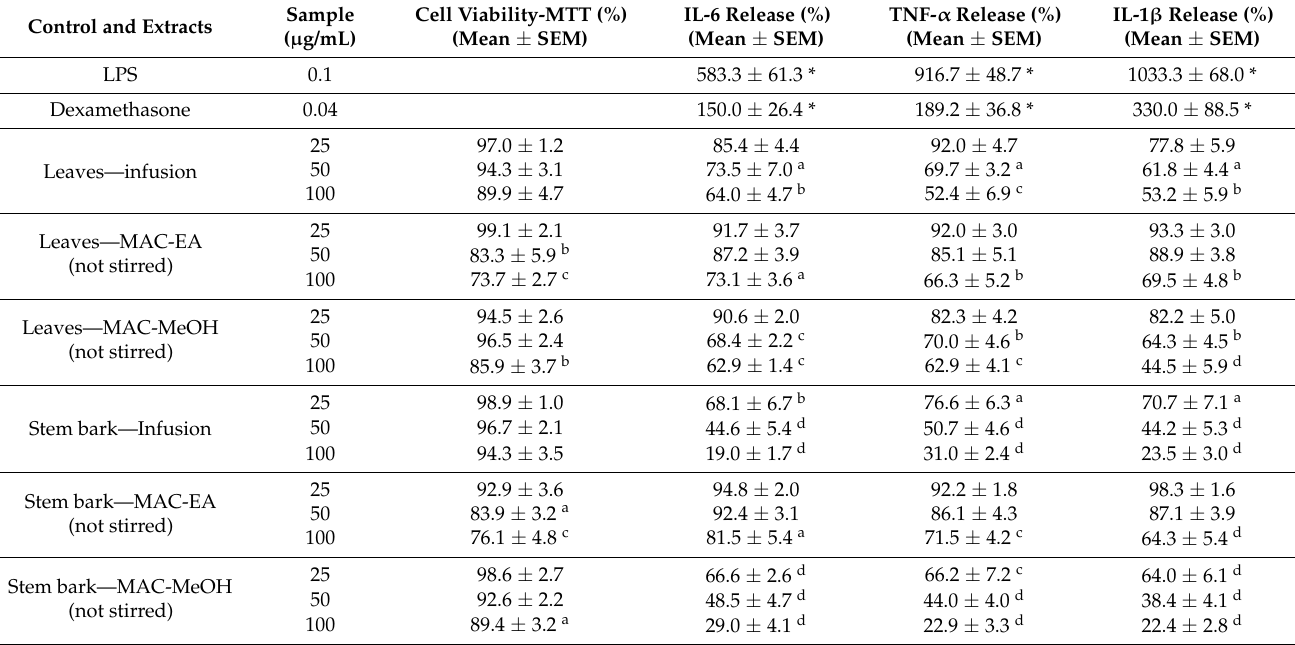
Table 10. Effects induced by Alstonia boonei extracts on cell viability and LPS-induced cytokine release (IL-6, TNF- α and IL-1 β ) in macrophages. Macrophages were exposed for 24 h to 25, 50 and 100 µ g/mL of extracts. a is for p < 0.05, b is for p < 0.01, c is for p < 0.001 and d is for p < 0.0001 vs. LPS. * is for absolute values in pg/mL. Data were statistically analyzed using One-Way ANOVA followed by Dunnett’s multiple comparisons test (n = 6 replicates of 2 separate sets of experiments). Results are expressed as mean ±